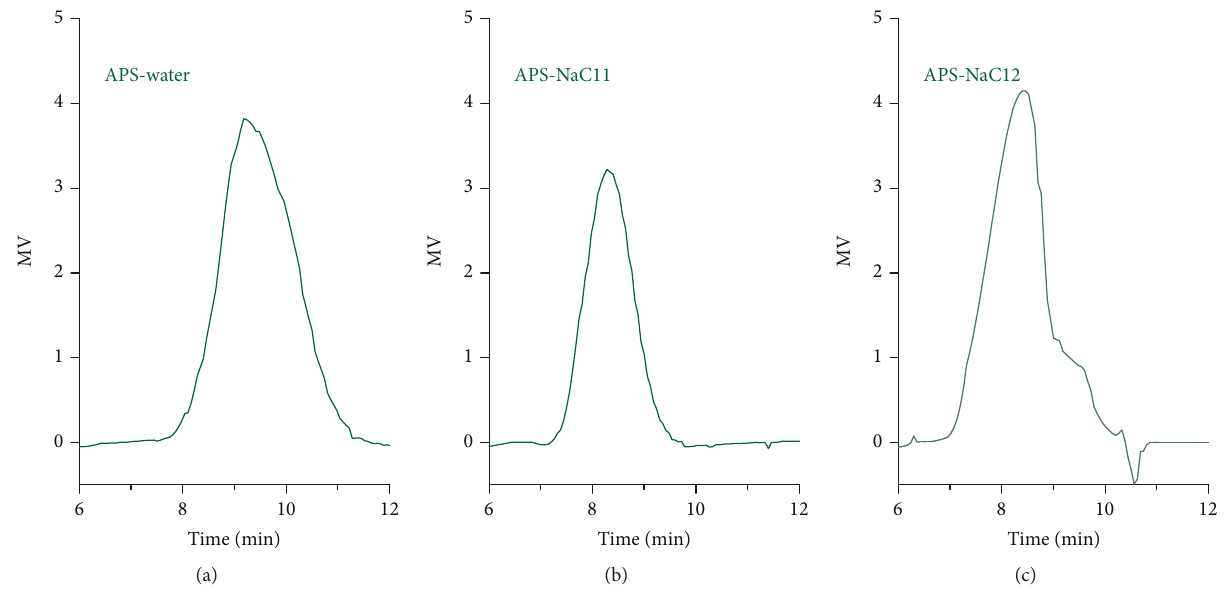
Figure 2: High-performance gel permeation chromatography (HPGPC) chromatogram of APS fractions (APS-water, APS-NaCl1, and APS-NaCl2) gained with a TSKgel G-3000PWXL liquid chromatography column. (a) APS-water in HPGPC. (b) APS-NaCl1 in HPGPC. (c) APS-NaCl2 in HPGPC.